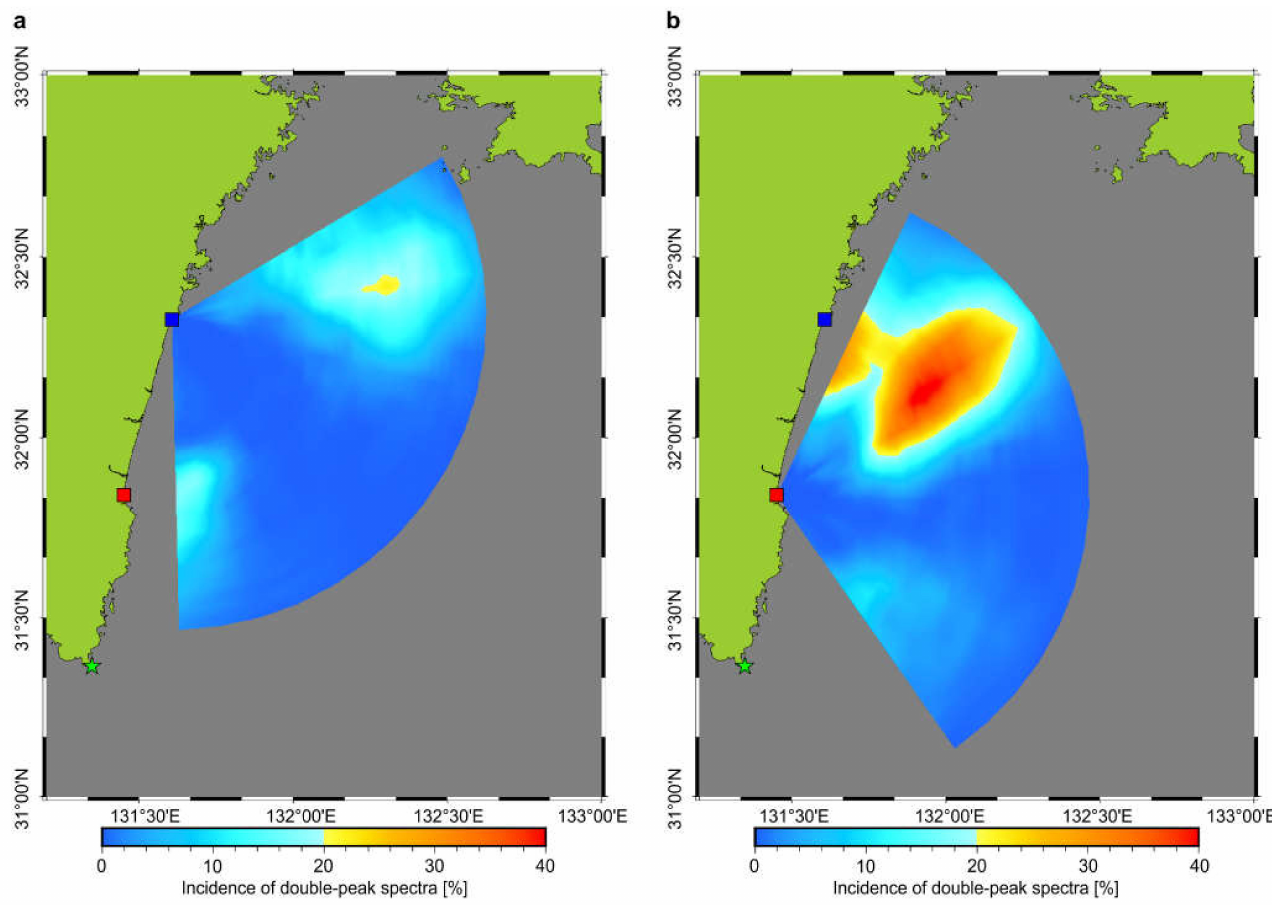
Figure 7. Example spatial distribution of double-peak spectra. The color change indicates the incidence of double-peak spectra in the area. ( a ) Spatial distribution of double-peak spectra at Mimitsu Station in January 2019. ( b ) Spatial distribution of double-peak spectra at Miyazaki Station in January